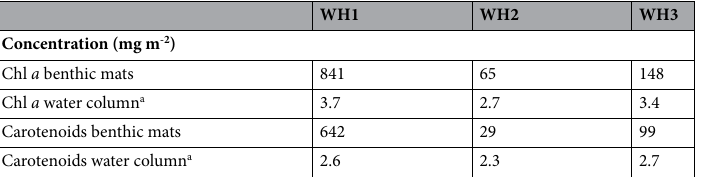
Table 1. Pigments in the benthic mats and phytoplankton of Ward Hunt Lake. Benthic core samples were from three mid-lake locations (WH1, WH2 and WH3) collected in July 2015. Total benthic pigment stocks per unit area are given for comparison with phytoplankton values integrated for the overlying water column at each site. a Integration using the mean concentrations from three samples at each of the two depths: 2.2 and 7.5 m.